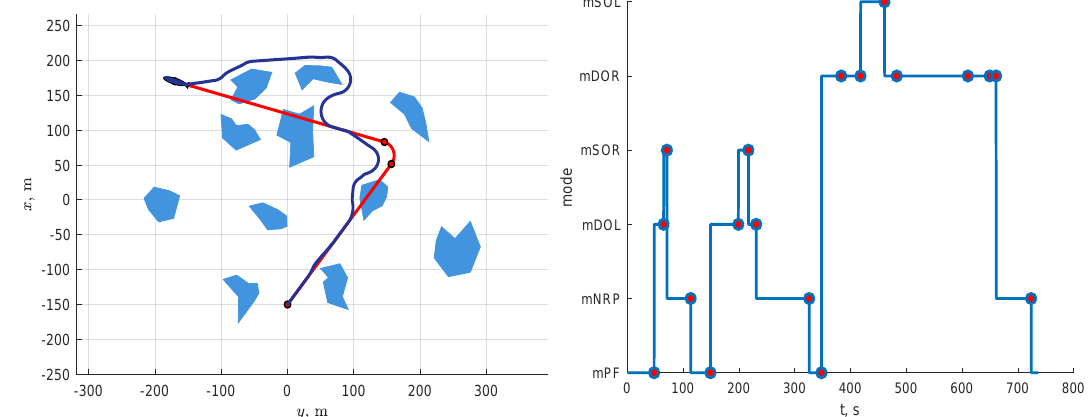
Figure 15. Simulation results for Scenario 3: cluttered environment. The explanation of the figure is the same as that of Figure